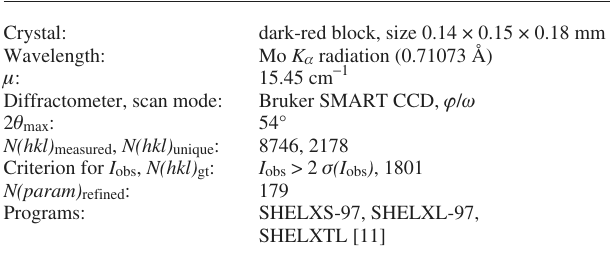
Table 1. Data collection and handling.